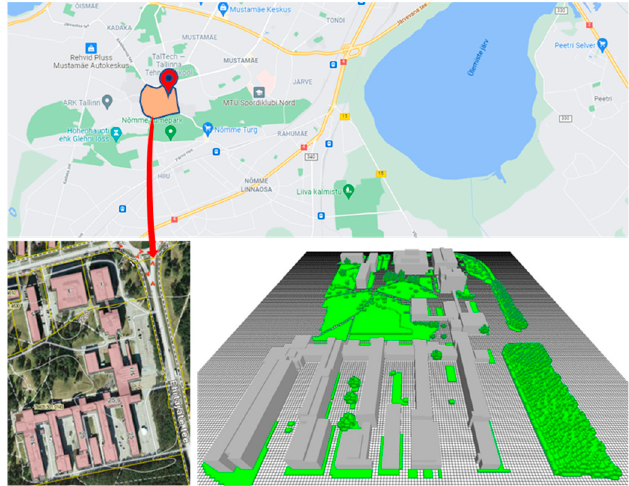
Figure 2. The location of Taltech main campus in Tallinn city map [39], top view of the buildings in the GIS map and the geometric 3D model in ENVI-met.